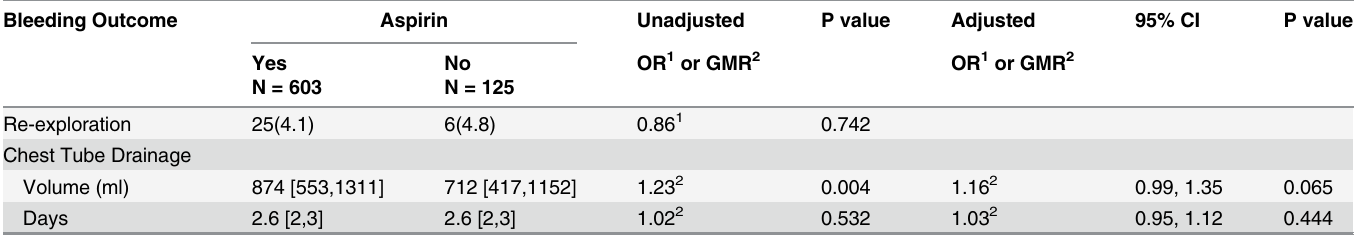
Table 3. Postoperative Bleeding, Aspirin vs No Aspirin. Bleeding